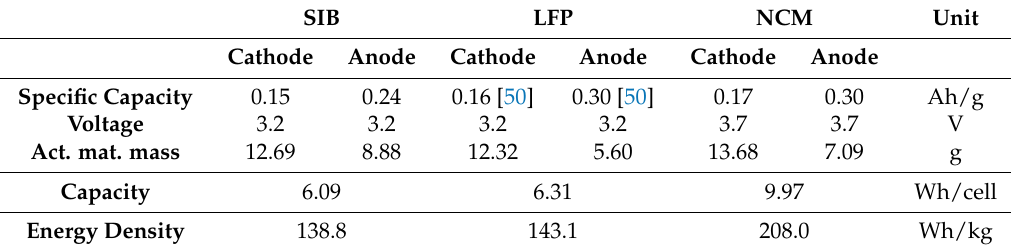
Table 4. Performance parameters per single 18650 battery